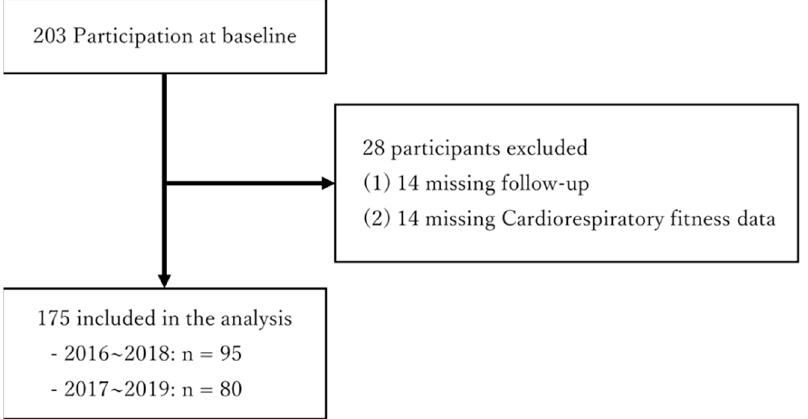
Figure 1. Flow chart of participation, detailing loss to follow-up and final participant sample used in this study (n = 175).